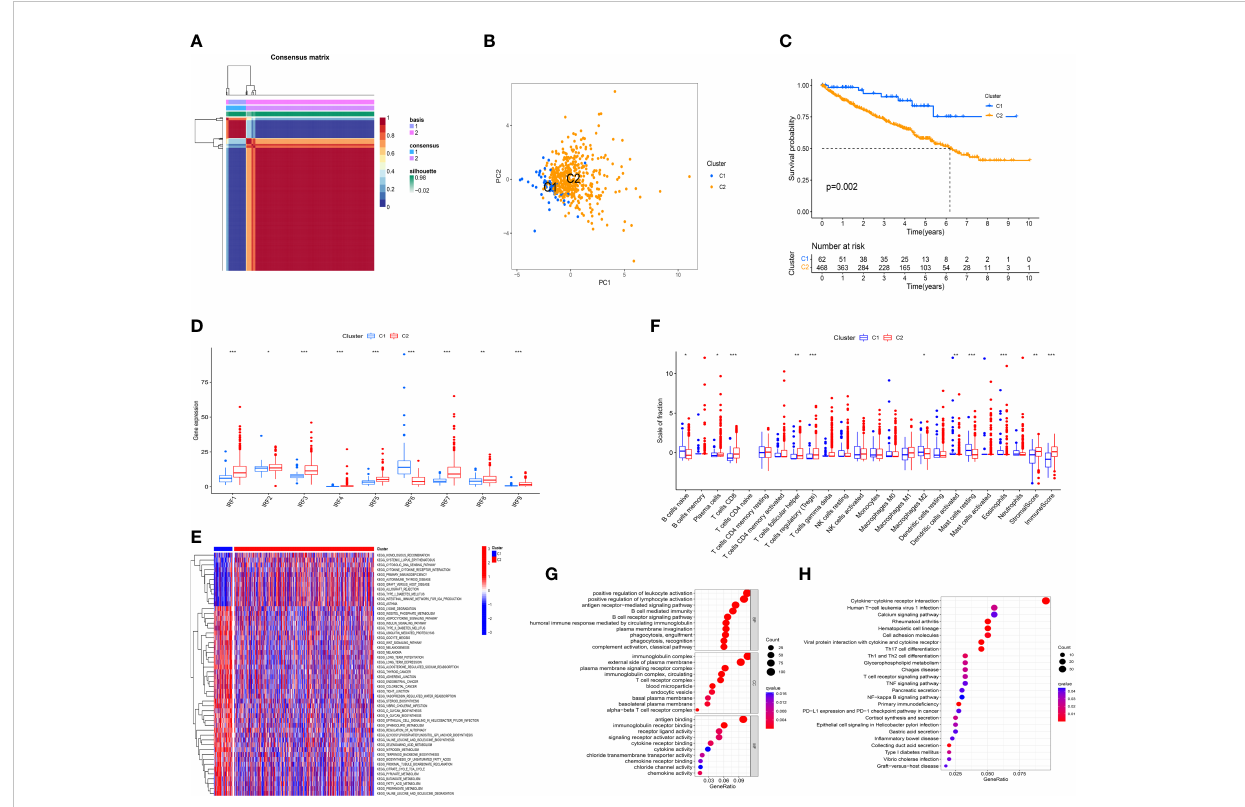
FIGURE 4 Identi fi cation of IRFs-related molecular subtypes. (A) Consensus map of NMF clustering (k = 2). (B) PCA plot of the expression pro fi ling of IRFs. (C) KM analysis of OS between the two molecular subtypes. (D) The differences in the expression levels of IRF family members between the two molecular subtypes. (E) Heatmap of biological pathways between the two molecular subtypes. Activated and inhibited pathways are colored by red and blue, respectively. (F) The differences in immune score, stromal score and immune in fi ltrating cells between the two molecular subtypes. (G) GO enrichment analysis of DEGs between the two molecular subtypes. (H) KEGG pathway enrichment analysis of DEGs between the two molecular subtypes. * p <0.05, ** p <0.01, *** p